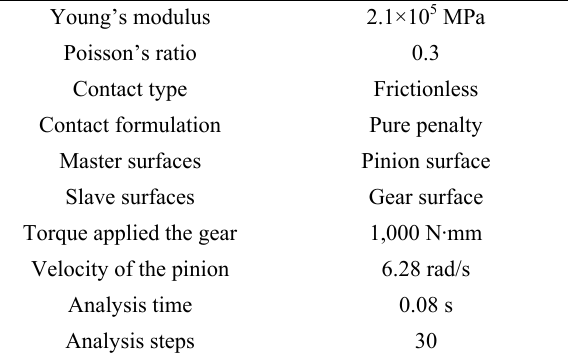
Table 2 Setting for the finite element analysis.